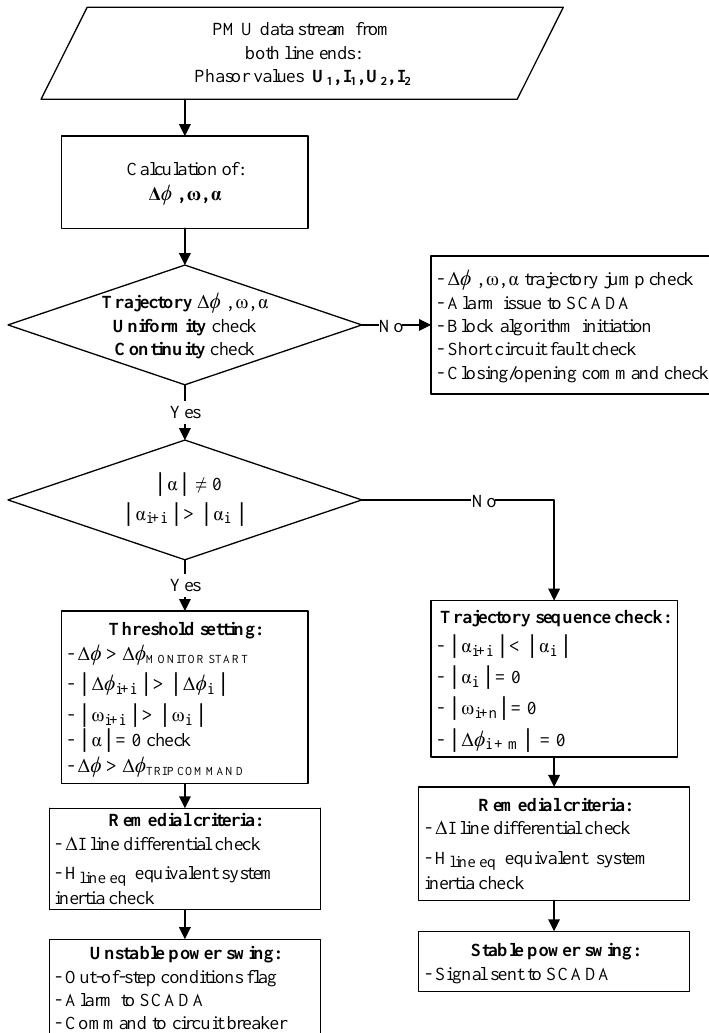
Figure 9. Flow chart of the algorithm for active power oscillations and out-of-step condition detection and early warning issuing.